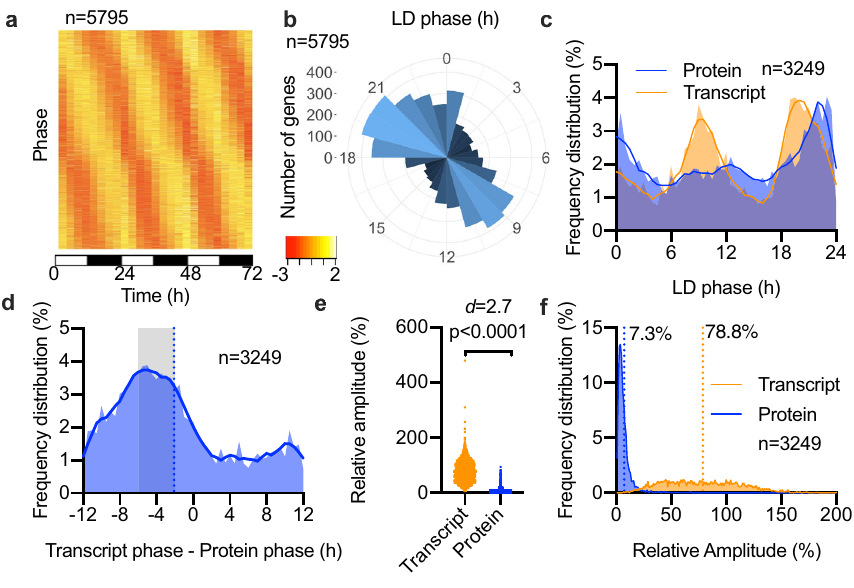
Fig. 4 Partial correlation between transcript versus protein abundance. a Heat map showing min – max (red-yellow; Z-scores as indicated) normalised plots for all rhythmic transcripts following a reappraisal of published data 21 under entrained conditions. b Circular histogram showing the number of rhythmic transcripts in LD at each 1-hour peak phase interval. c Frequency distribution of protein or transcript peak phase under LD conditions, for those where both gene products were rhythmic. d One-for-one phase harmonics between rhythmic proteins and their rhythmic transcript, expressed as peak phase of transcript minus peak phase of protein. The mean value is indicated by a dotted line, and values that correlate with a protein peaking in a 2 – 6 h window after the transcript are indicated with a shaded box. e – f Relative amplitude values ( e ) and frequency distribution of relative amplitude ( f ) of transcripts versus proteins under LD conditions. Statistics re fl ect Mann – Whitney tests and Cohen ’ s d . Source data can be found in Supplementary Data